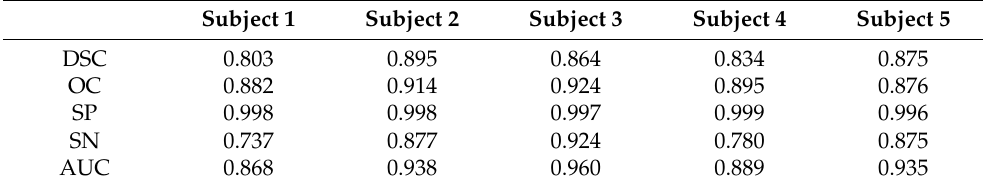
Table 3. Evaluation results for model M1 in our